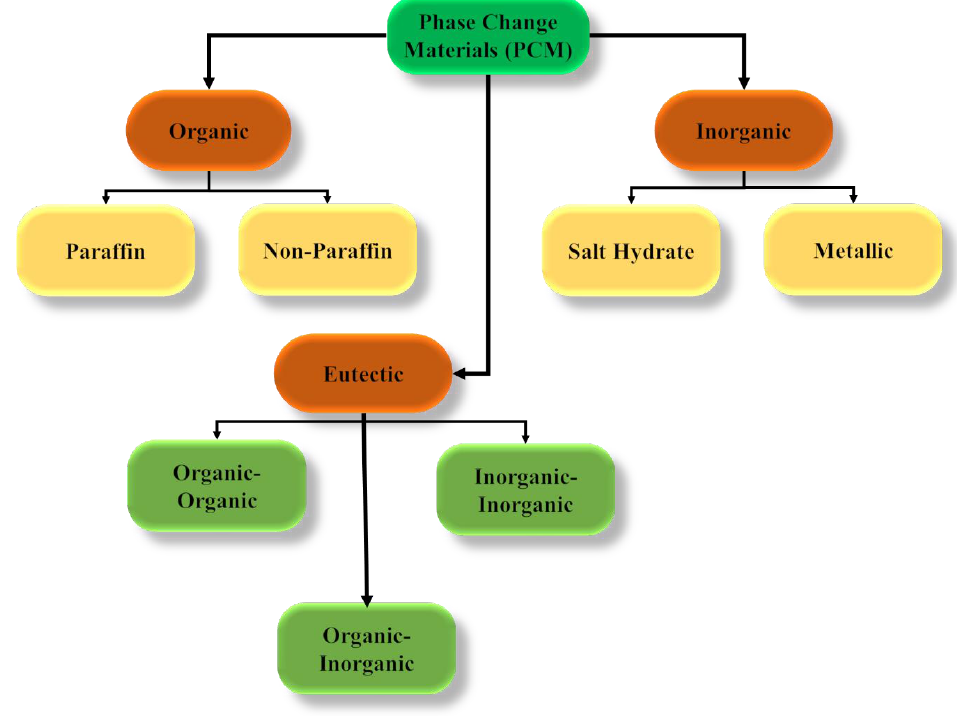
Figure 4. Classification of